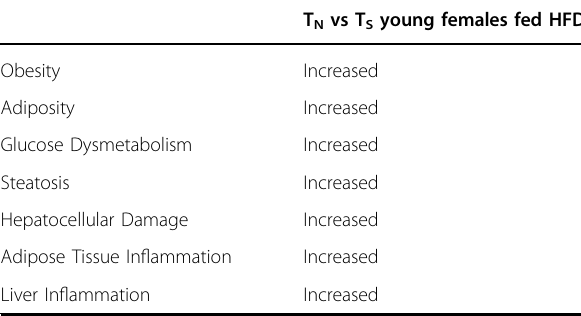
Table 1 Thermoneutral housing, compared to standard housing, promotes severe obesity, metabolic dysfunction and ampli fi es tissue in fl ammation in young female